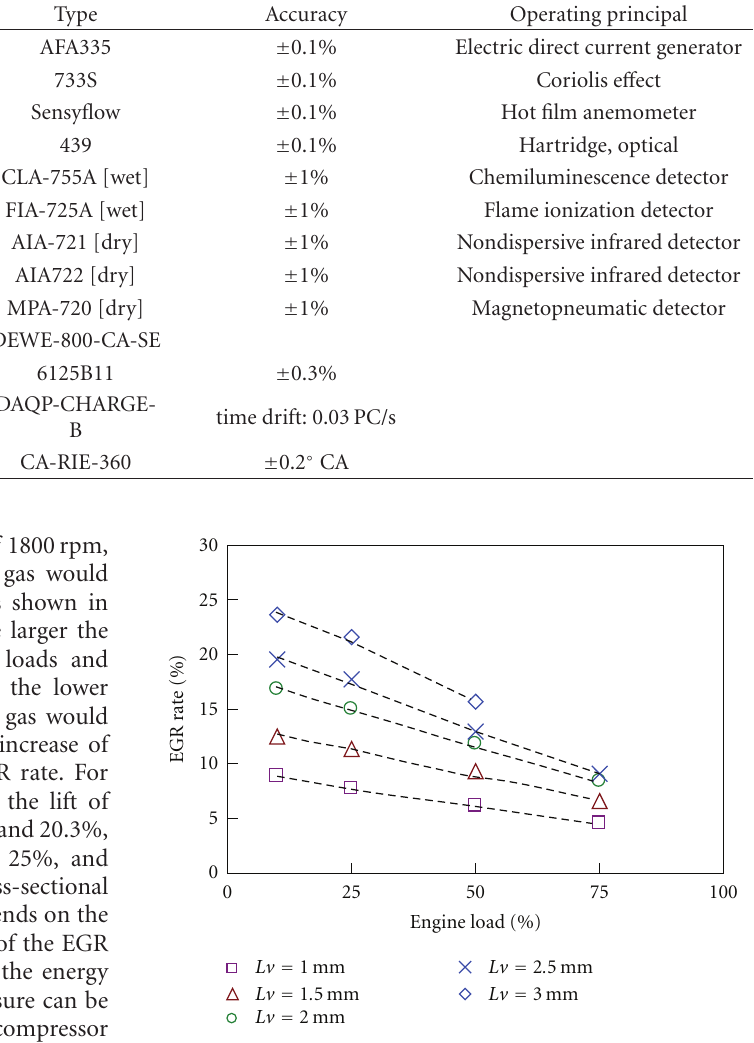
Figure 2: Flow characteristics of EGR